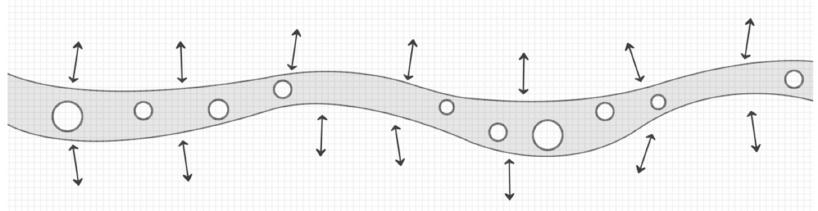
Figure 1. Schematic diagram of the linear space and surrounding organic relationship of the scenic